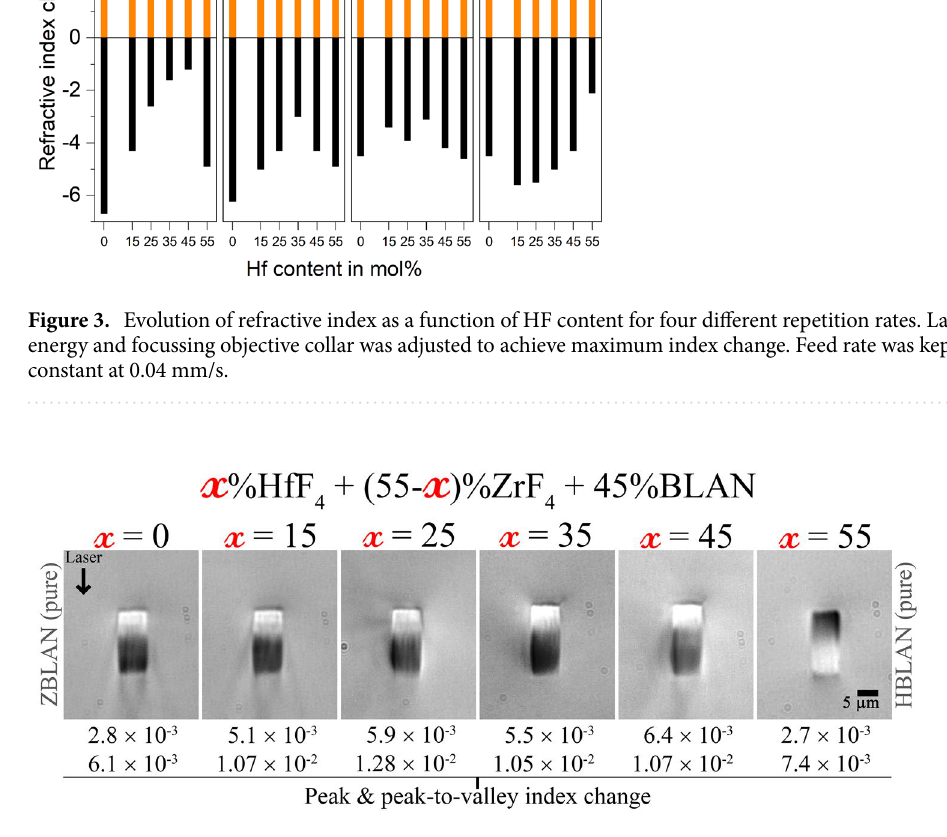
Figure 4. DIC images of waveguides written in all compositions at 5 kHz, 500 nJ, 0.04 mm/s and focussing objective collar set to 1000